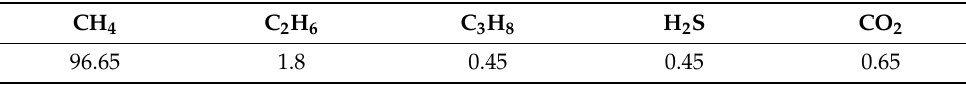
Table 6. Components of the natural gas.